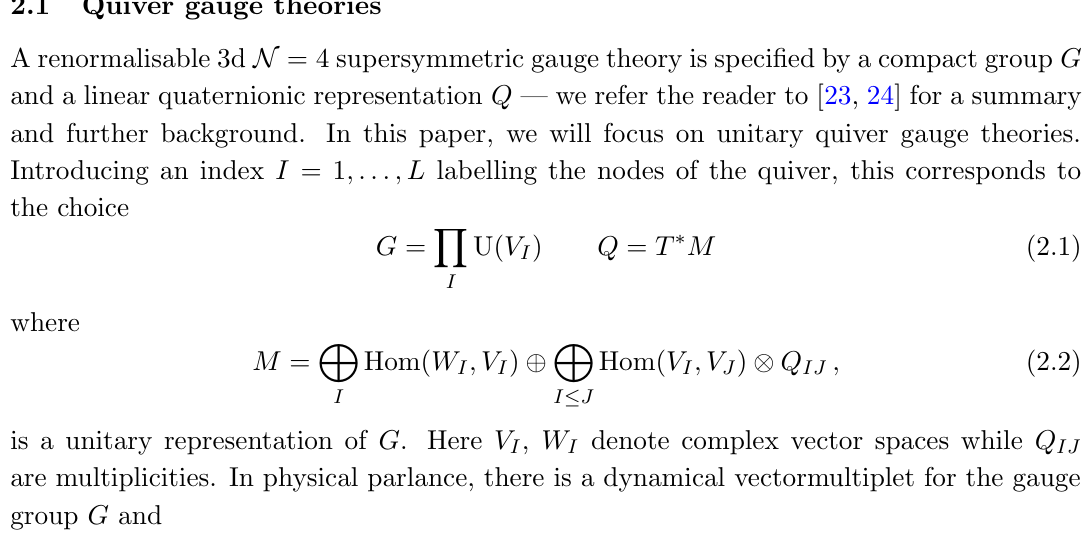
) supersymmetric QCD with N c